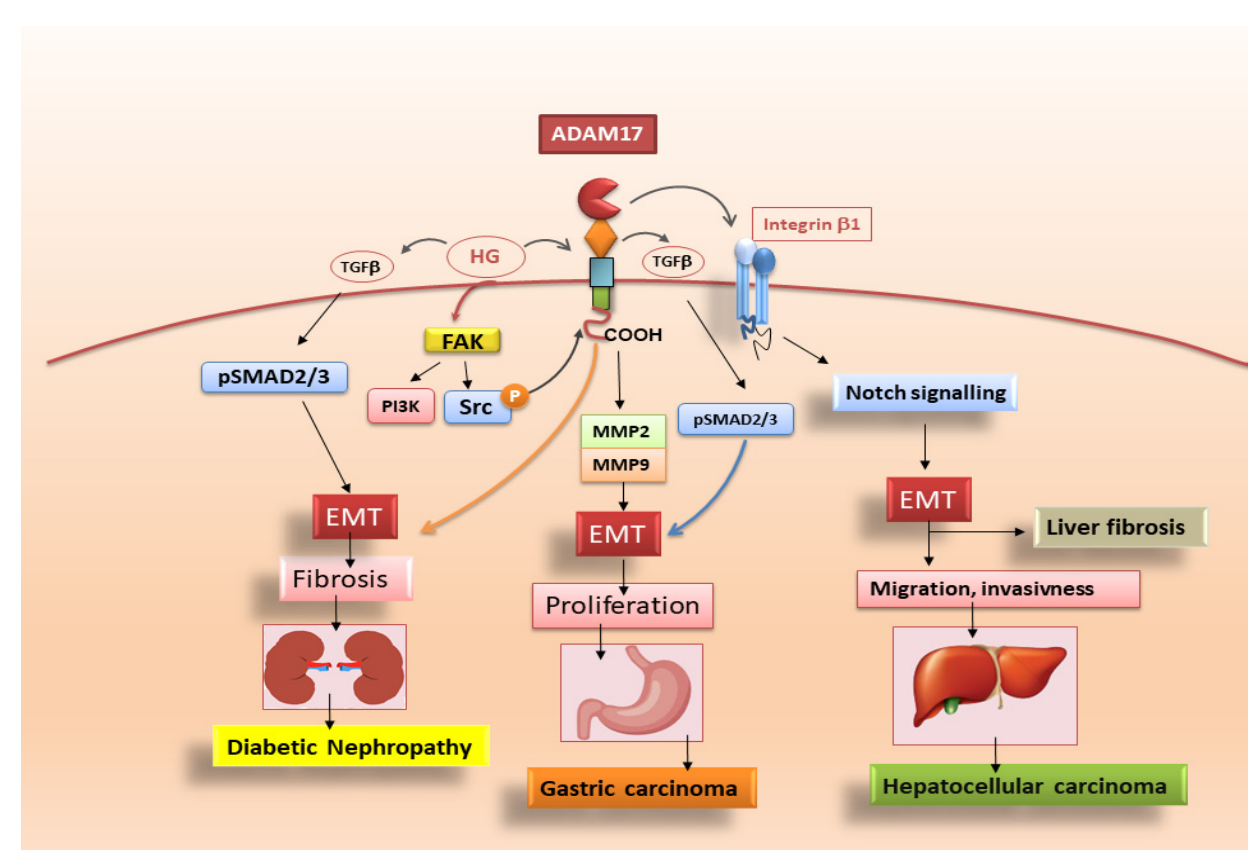
Figure 4. A simplified representation of signalling pathways triggered by ADAM17 in diabetic nephropathy, gastric carcinoma and liver fibrosis. ADAM17 activation is required for high glucose (HG)-induced upregulation of the TGF- β 1. HG also induces maturation of ADAM17 on the cell surface. Furthermore, FAK is identified as a central upstream regulator of HG-induced ADAM17 activation through its recruitment of both Src and PI3K, with subsequent phosphorylation of ADAM17. In addition, ADAM17, through an increase in MMP-2 and MMP-9 expression, induces EMT in gastric carcinoma cells. Finally, the role of ADAM17 in promoting EMT of HCC cells involves the activation of Notch signalling pathway, which occurs through Notch proteolytic cleavage.